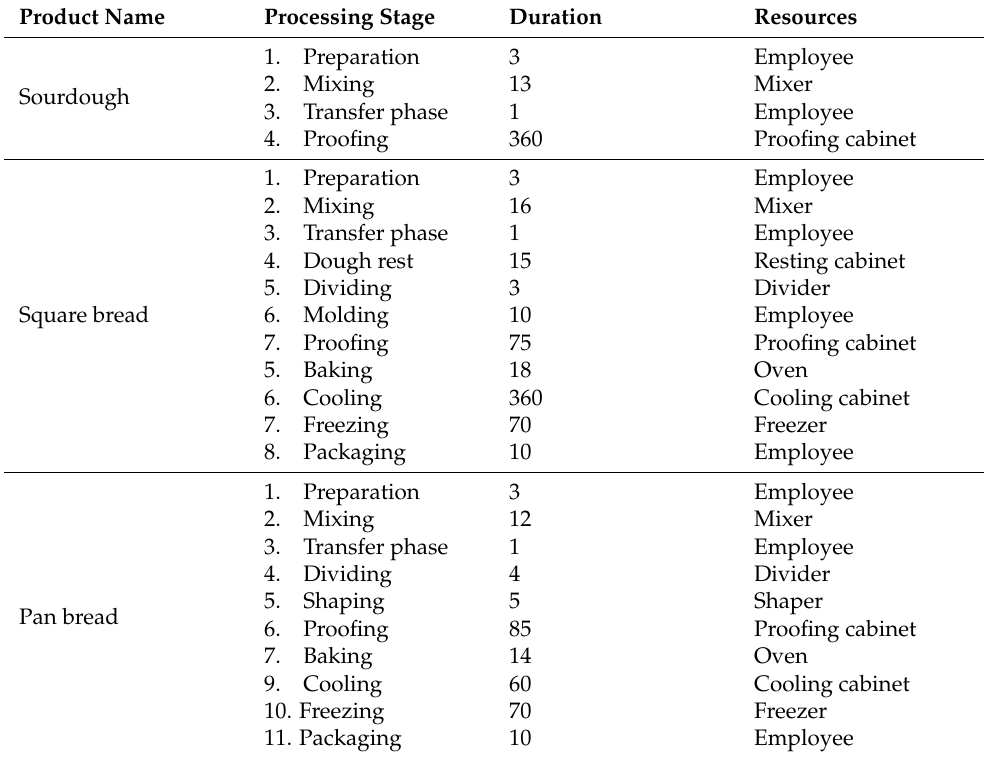
Table 1. Example production data for three